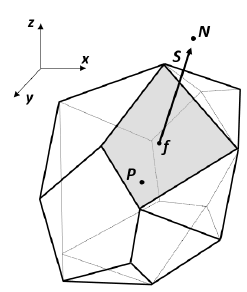
Figure 1. A typical control volume (mesh cell) used for the dis- cretization of the solution domain using FVM. The control vol- ume represents a portion of the continuum and not a reference particle. Its size is defined by the numerical stability criterion of the system and the mesh independence of the results which may lead to volumes smaller than a